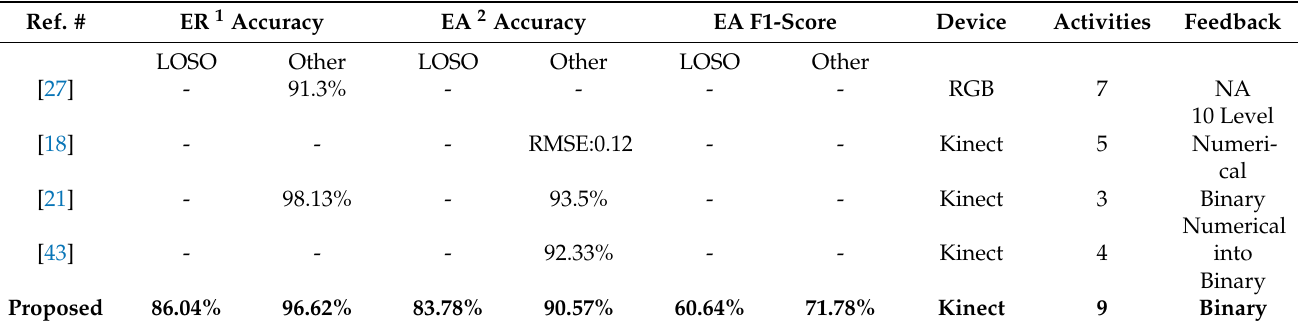
Table 5. A comparison of our work to the most recent similar